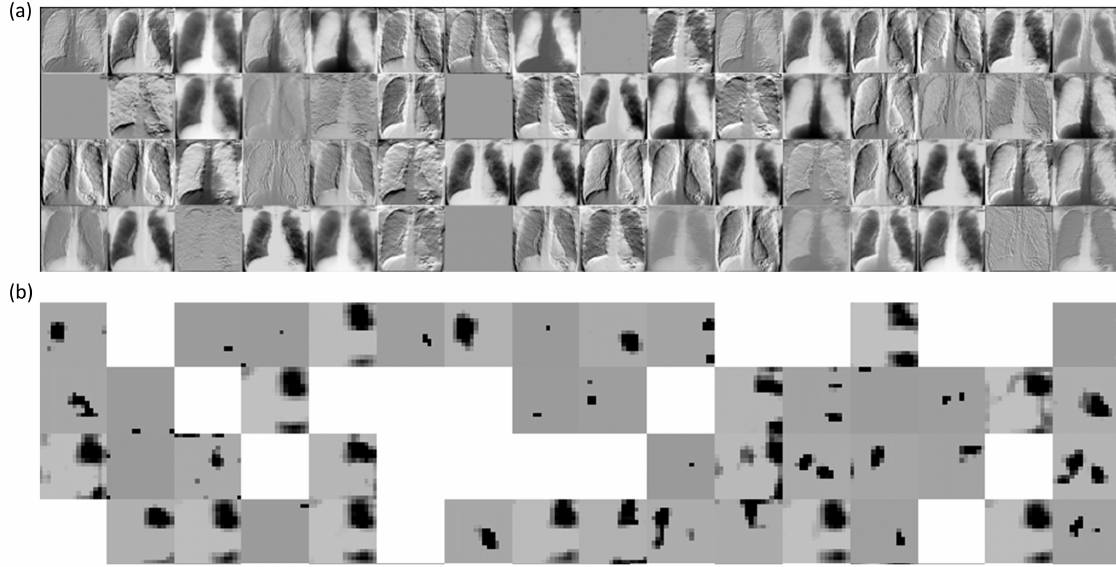
Figure 11. Visualizing the activations of the first 64 filters using the best-performing bone-suppressed model with a sample CXR from the Montgomery TB collection. The layer naming conventions follow Keras DL library. ( a ) block1-Conv1 layer and ( b ) block5-conv3